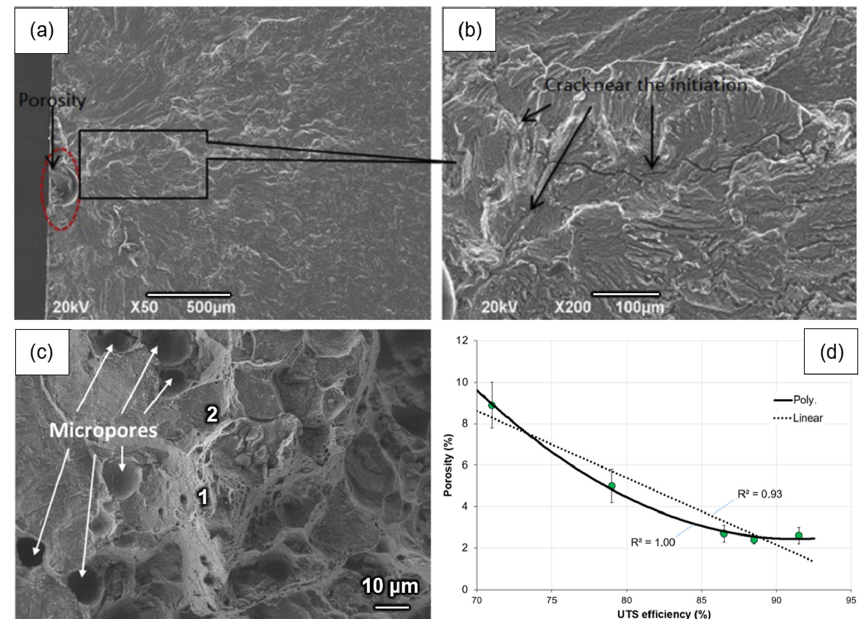
Figure 19. ( a ) Porosity in LAHW as fatigue initiation point with ( b ) cracking [282]. ( c ) Typical microporosity with mixed ductile dimples (no. 1) and brittle quasi-cleavage (no. 2) fracture morphologies using scanning electron microscope [284]. ( d ) Effect of porosity on ultimate tensile strength (UTS) to base metal ratio in case of autogenous LBW of 3 mm AA5083 showing strong polynomial and linear correlation, modified, and redrawn from [285].